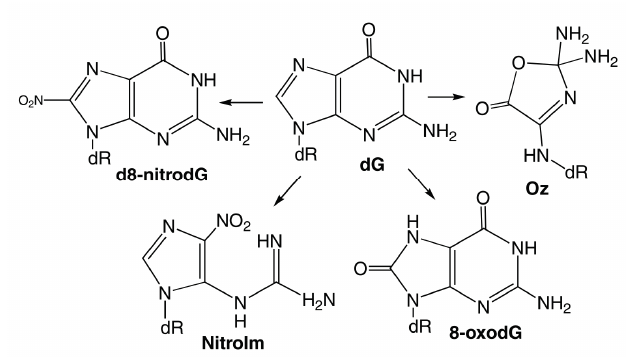
Figure 4. Products of peroxynitrite oxidation of dG. Adapted from [94] with the permission of Elsevier, Inc., 2004.